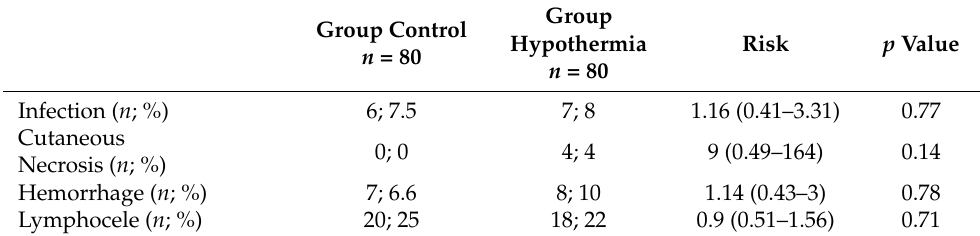
Table 2. Surgical sites complications.